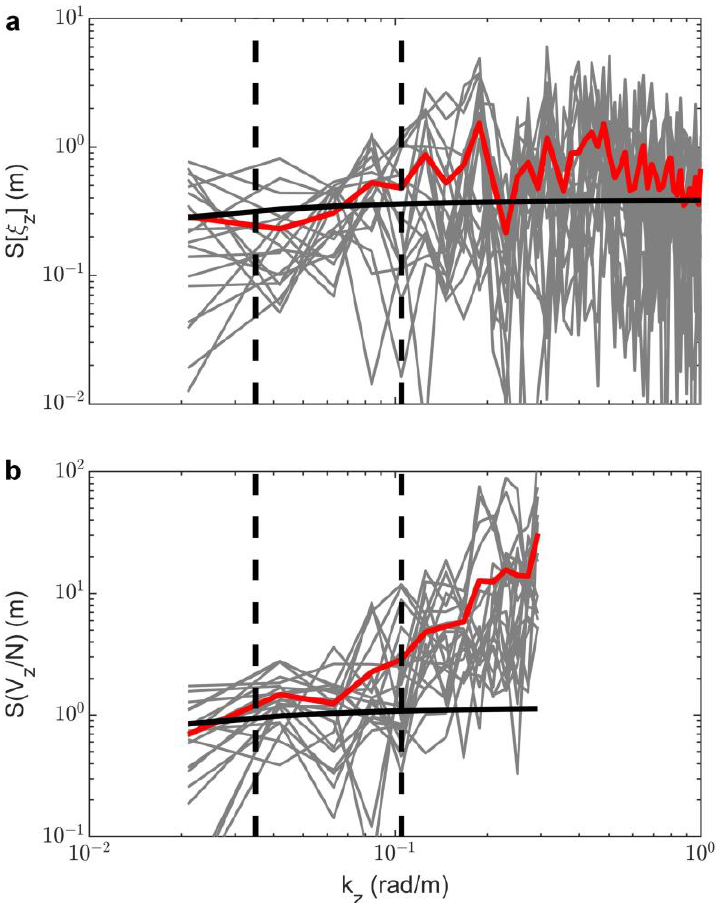
Figure 4. (a) The strain and (b) shear spectra of CTD/LADCP cast 1. The grey lines are spectra at each segment of different depths, the red line represents the average spectra along the vertical wavenumber, and the dash line represents the integration limitation.